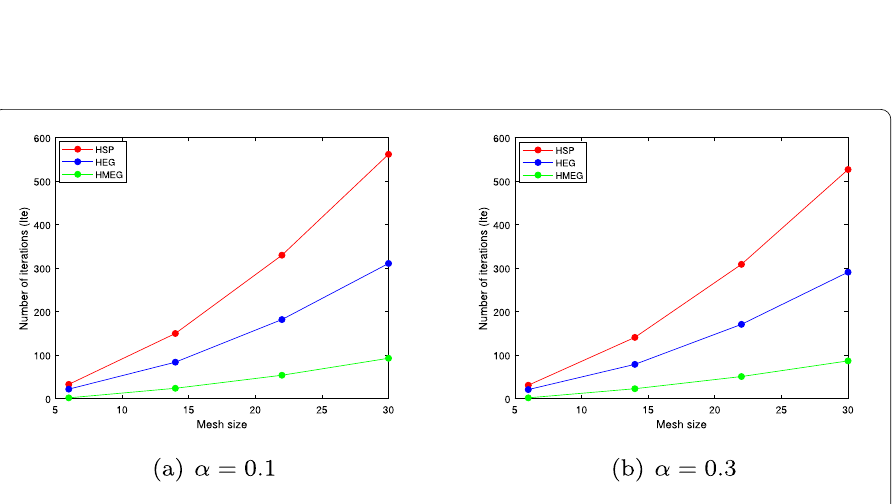
Figure 4 Iterations number plot of the HSP, HEG and HMEG methods for Example 5.1